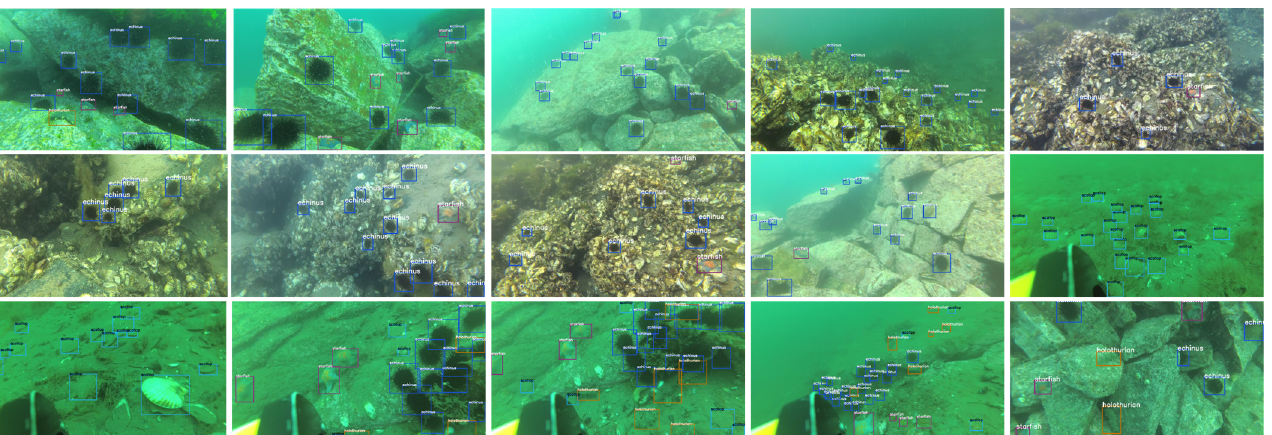
Figure 4. The qualitative comparison results of the original YOLOX-S and the proposed FFT_YOLOX model. 3.3. Ablation Study We investigated how the designed FFT_Filter block in FFT_YOLOX influenced the whole performance of the detection model. Table 3 (The best results are illustrated with bold format) exhibits the performances in detail. The 0.5–0.95 AP metric of original YOLOX-S was taken as a baseline, demonstrating that the accuracy of 0.5–0.95 AP is 0.480 without FFT_Filter block. Then, we removed the FFT_Filter to replace the 3 × 3 block with the dark2-5 blocks of the YOLOX_S model. To illustrate, we designed four different mod- els (exp2, exp3, exp4, exp5), which adds CSP_FFT block in dark2-5, dark3-5, dark4-5, and dark5 modules, respectively. As shown in Table 3, the proposed FFT_YOLOX (exp2) model, where CSP_FFT blocks were introduced in all dark2-dark5 modules of the original YOLOX-S model, had the highest accuracy of 0.5–0.95 AP with fewest model parameters and lowest FLOPs. Specifically, the accuracy of 0.5–0.95 AP of FFT_YOLOX (exp2) model, where only one CSP_FFT block was introduced as the dark5 module of the original YOLOX-S model, is also at a high level. This demonstrates that our proposed FFT_Filter enhanced the ability of global feature extraction even within a deep layer of a convolution network. Furthermore, for qualitative comparison, the detection results of different